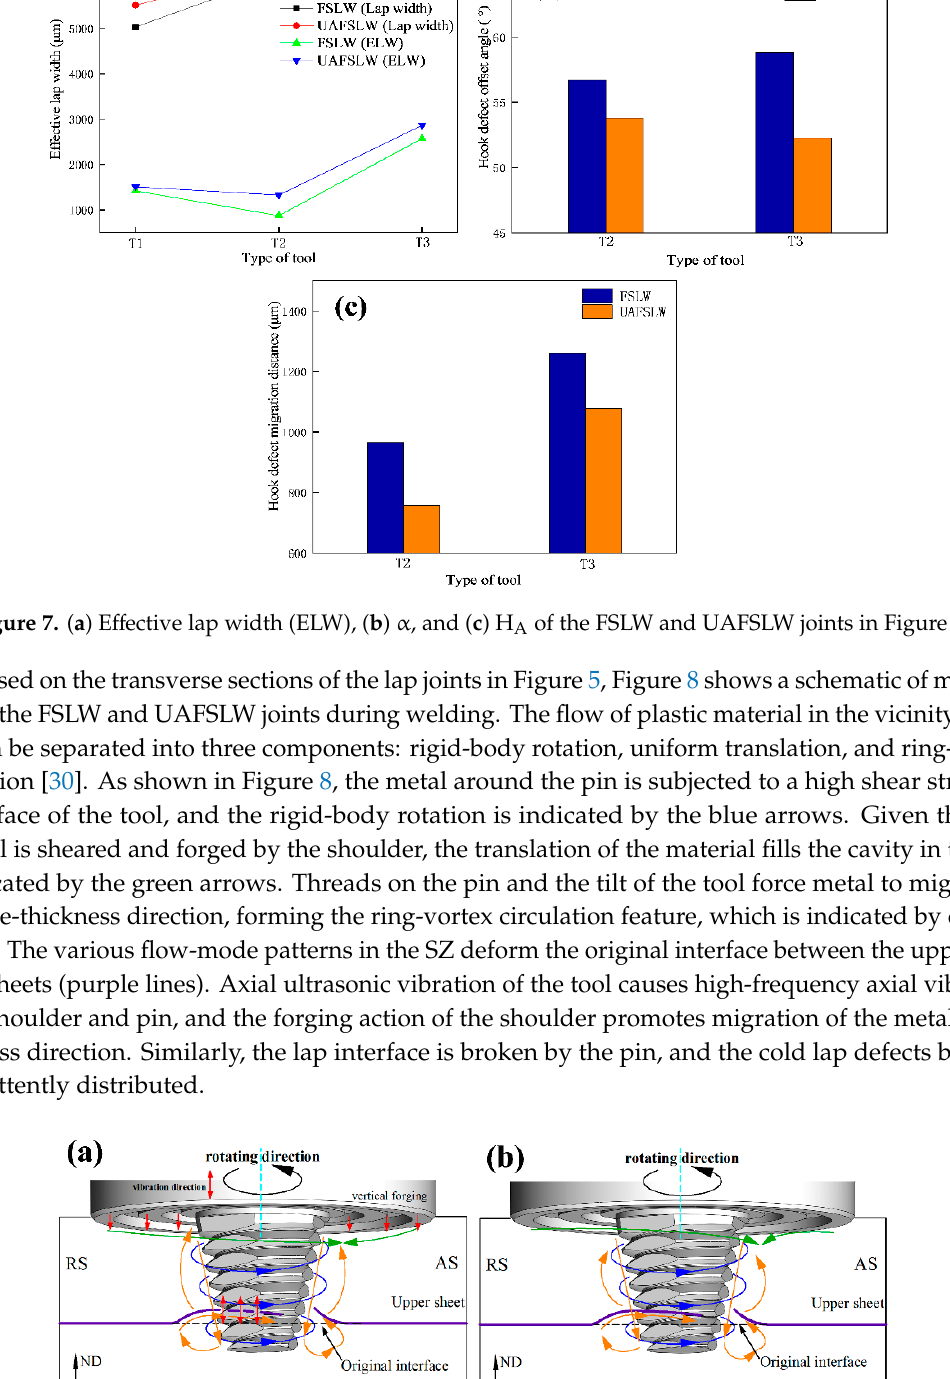
Figure 6. Longitudinal cross section (C 0 –C 1 ) of lap joints produced by tool T2: ( a ) FSLW joint and ( b ) UAFSLW joint.